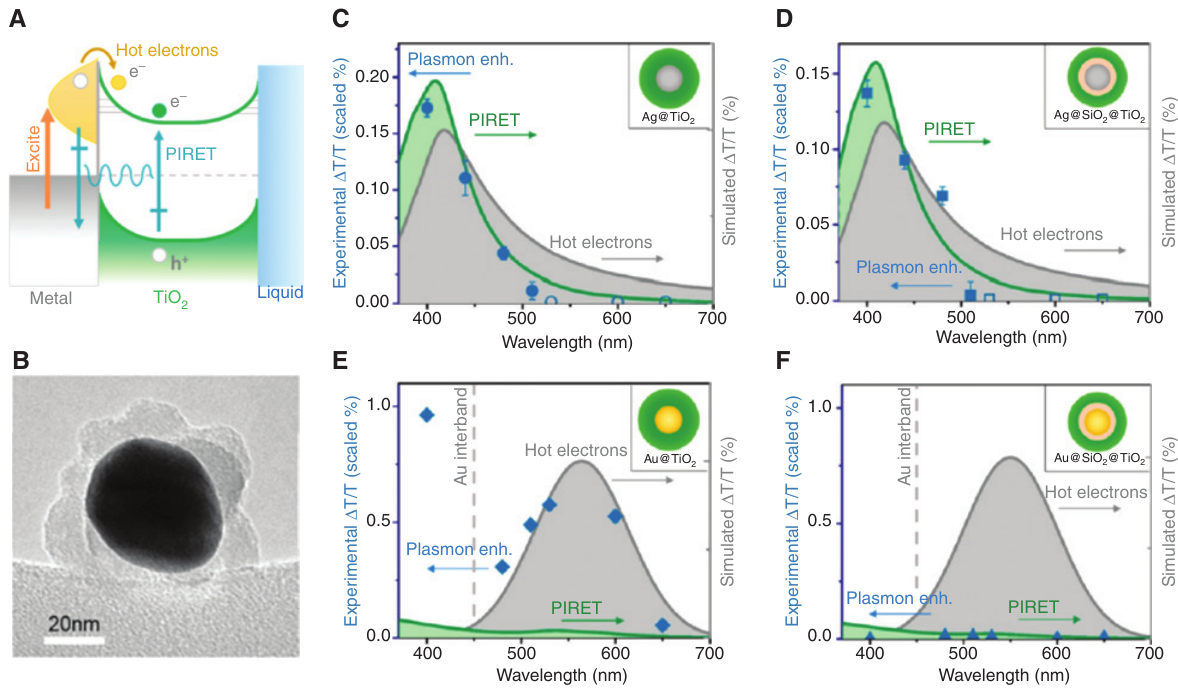
Figure 6: Plasmon enhanced photocurrent in dye-sensitized solar cells. (A) Illustration of the two mechanisms contributing to the plasmon energy conversion in metal@TiO core/shell NPs. (B) Characteristic 2 transmission electron microscopy (TEM) image of an Ag@SiO NP. (C) In the case of Ag@TiO colloids, contact and spectral overlap exist 2 2 between metal and semiconductor, such that both PIRET and hot electron injection processes are mutually detected. (D) Addition of an SiO 2 barrier to Ag@TiO eliminates hot electron injection. (E) Switching the metal core to Au eliminates spectral overlap and PIRET. (F) Inserting a 2 SiO barrier in Au@TiO eliminates both hot electron injection and PIRET despite strong light absorption by the plasmonic Au. Adapted with 2 2 permission from Ref. [65]. Copyright 2015 American Chemical